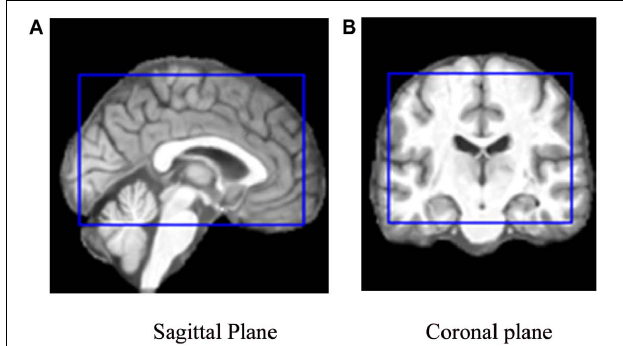
FIGURE 2 | The cropping range (inside the blue rectangle) of the slices used to train the model on (A) a sagittal plane and (B) a coronal plane, respectively. (A) Sagittal Plane. (B) Coronal